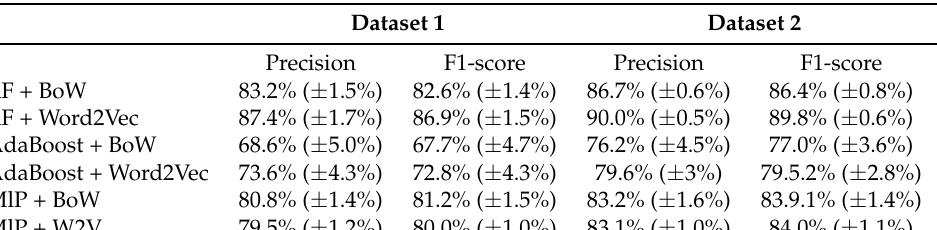
Table 2. Mean cross validation precision and f1-score of the classifiers which predict account codes (received invoices). Standard deviation is reported in parentheses.